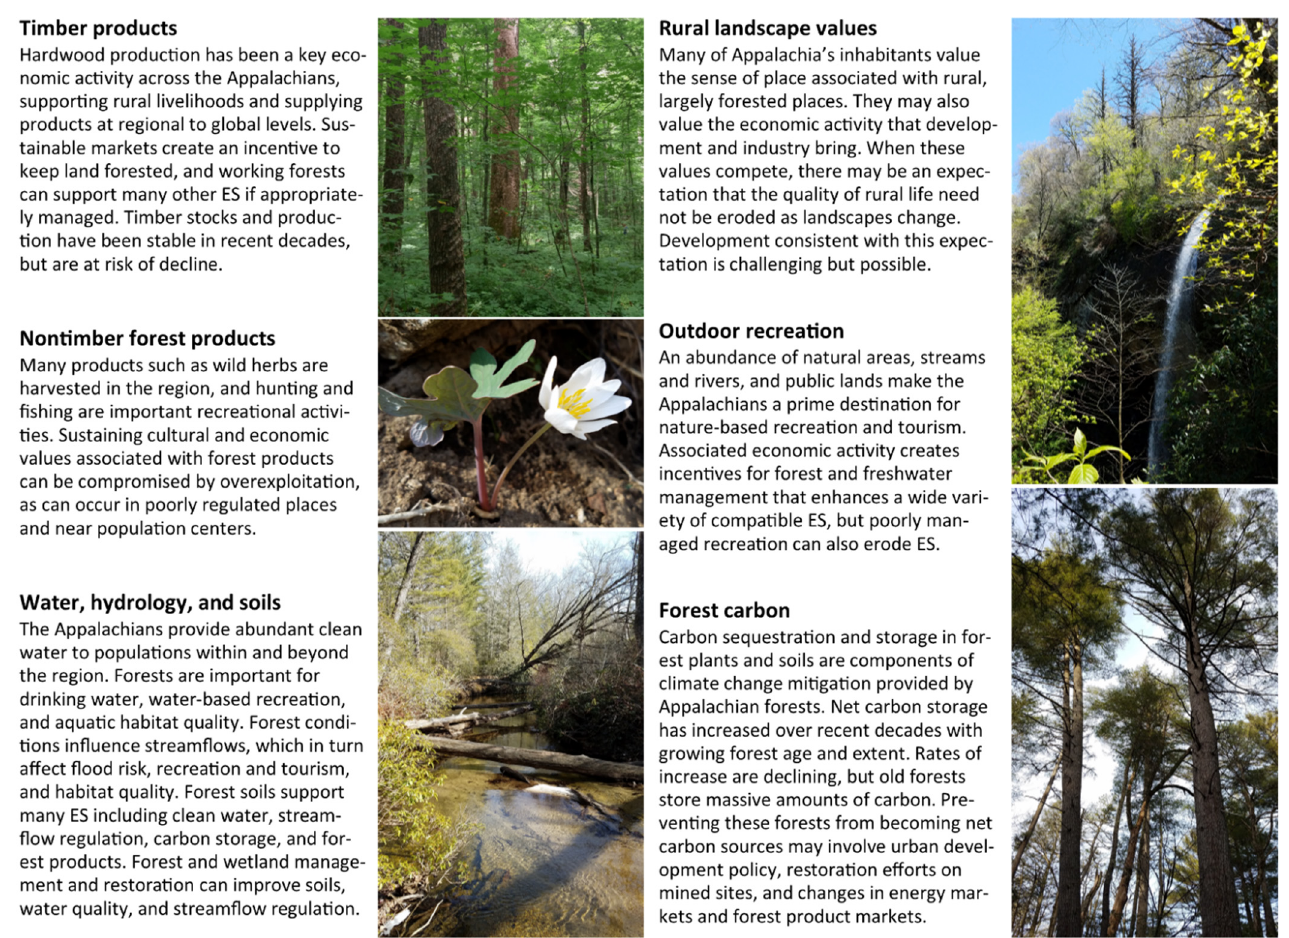
Figure 3. Ecosystem services provided by forested landscapes are abundant and diverse. Principles of ecosystem manage- ment highlight the importance of understanding these ES as integral components of entire ecosystems with dependencies on ecological processes at multiple scales and system organizational levels. Examples of ES described here were among those most frequently included in ecological assessment documents for the Appalachian region; statements regarding sustainability and management were synthesized from these documents (Appendices A and B—the ES shown here are further grouped into four categories in Appendix B). The flowering plant pictured at left is Bloodroot ( Sanguinaria canadensis ), a species harvested for use in the medicinal trade. Photos by the first author in western North Carolina.